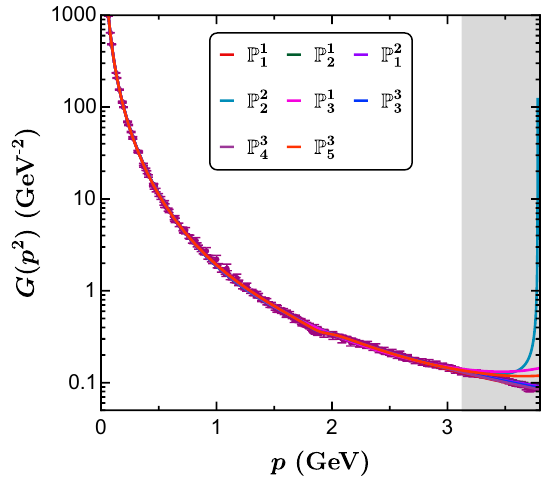
Figure 8 . Plot of the partial Padé approximants, used to determine our final results, and of the lattice data for the Landau-gauge ghost propagator. The shaded region — corresponding to p p = p 2 > 3 . 12 GeV — is not included in the